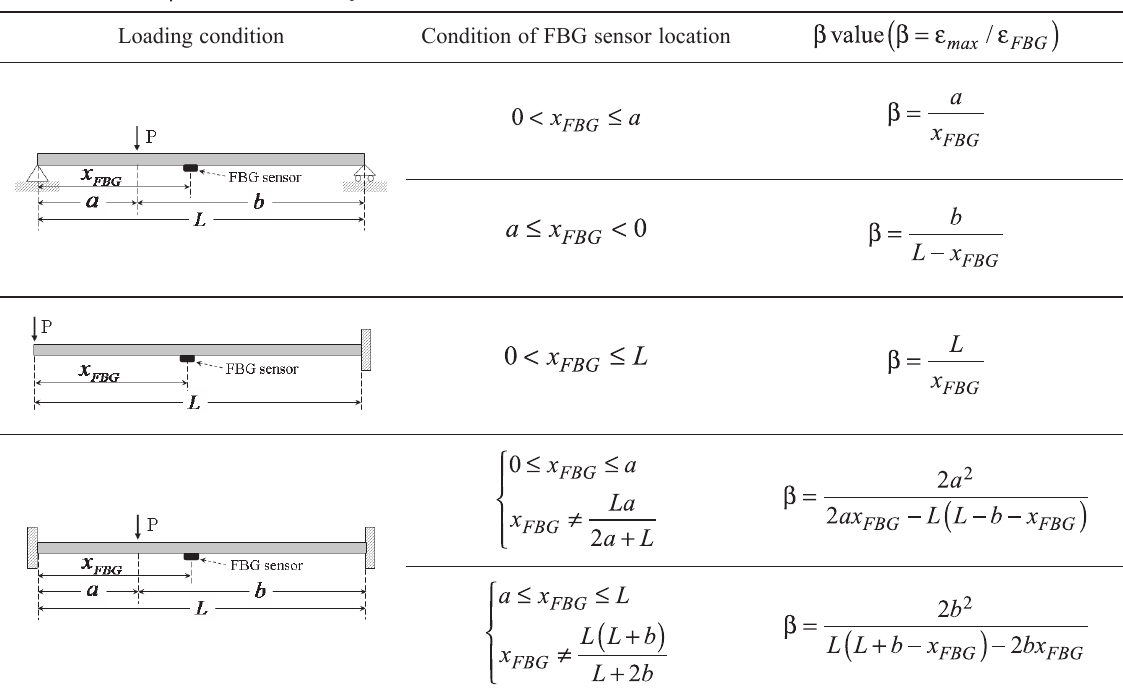
Table 2. Values of β for the beams subjected to concentrated